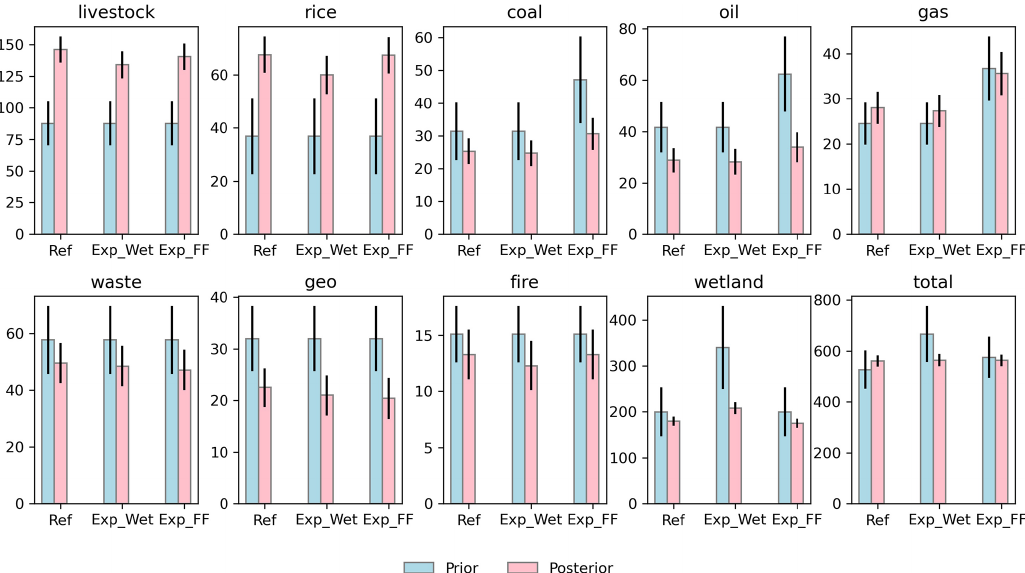
Figure 6. Comparison of total posterior emissions for the reference case (“Ref”, also Table 1 posterior) if prior wetland emissions are inflated (Exp_Wet) and if prior anthropogenic fossil emissions are inflated